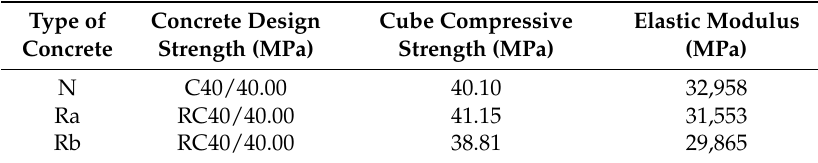
Table 3. Experimental results on the mechanical properties of concrete.